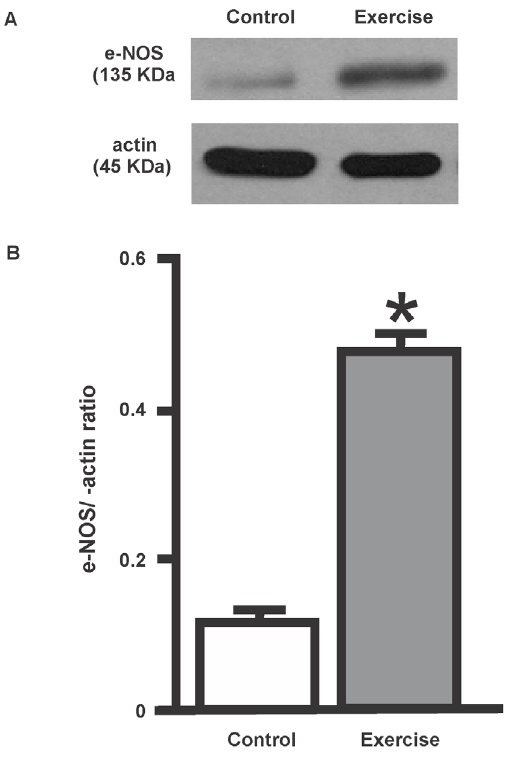
Figure 1. Effects of physical exercise on eNOS protein expression. A . Typical examples of Western blots for placental cytosolic fractions for each experimental group. Each blot was normalized to expression of b -actin from the same gel. B . Bars represent cytosolic eNOS/ b -actin ratios 6 SEM obtained after densito- metric analysis. (*p , 0.05, as compared with control value). The results shown are representative of three independent studies.